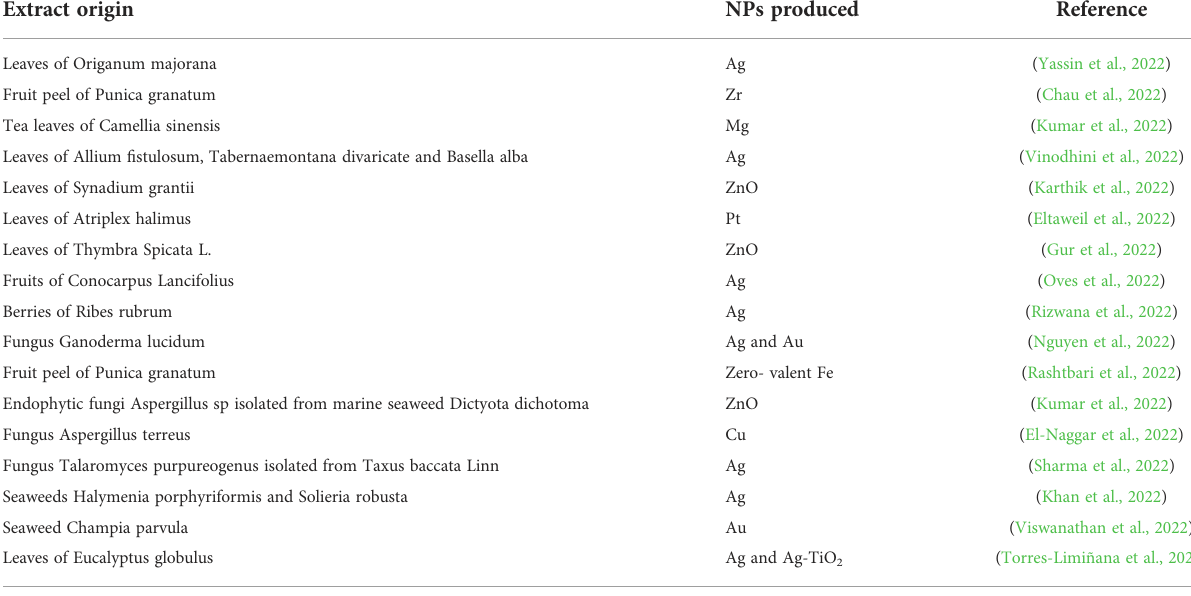
TABLE 1 Recent examples of the implementation of bacteria, fungi and plant extracts for the synthesis of NPs and NMs. Extract